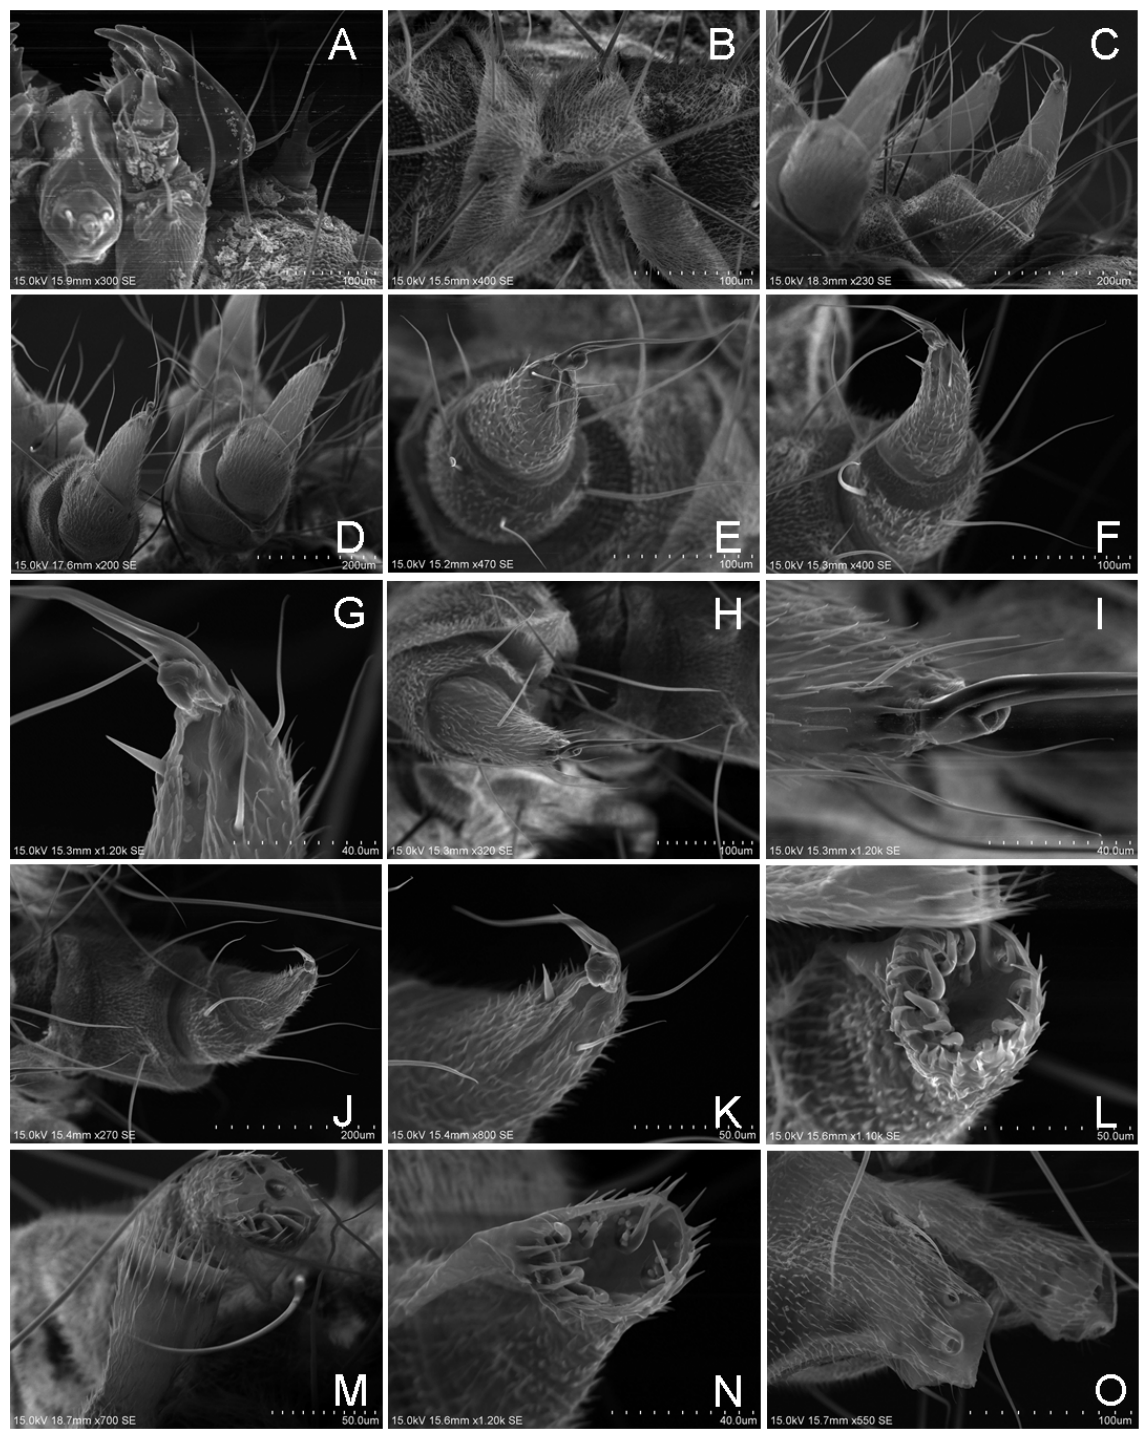
Fig. 9 . SEMs of the mature larval structure of Tonza citrorrhoa Meyrick, 1905 (OPU-IN- LE2018IV0035|SK543). A . Mandible and maxillary palpus. B . Jugular gland-like structure. C . Prothoracic legs. D . Meso- and metathoracic legs. E . Right mesothoracic leg. F . Left mesothoracic leg. G . Same, base of claw. H . Right metathoracic leg. I . Same, base of claw. J . Left metathoracic leg. K . Same, claw and tarsus. L – M . Crochets of proleg on A3. N . Same on A4. O . Crochets of anal